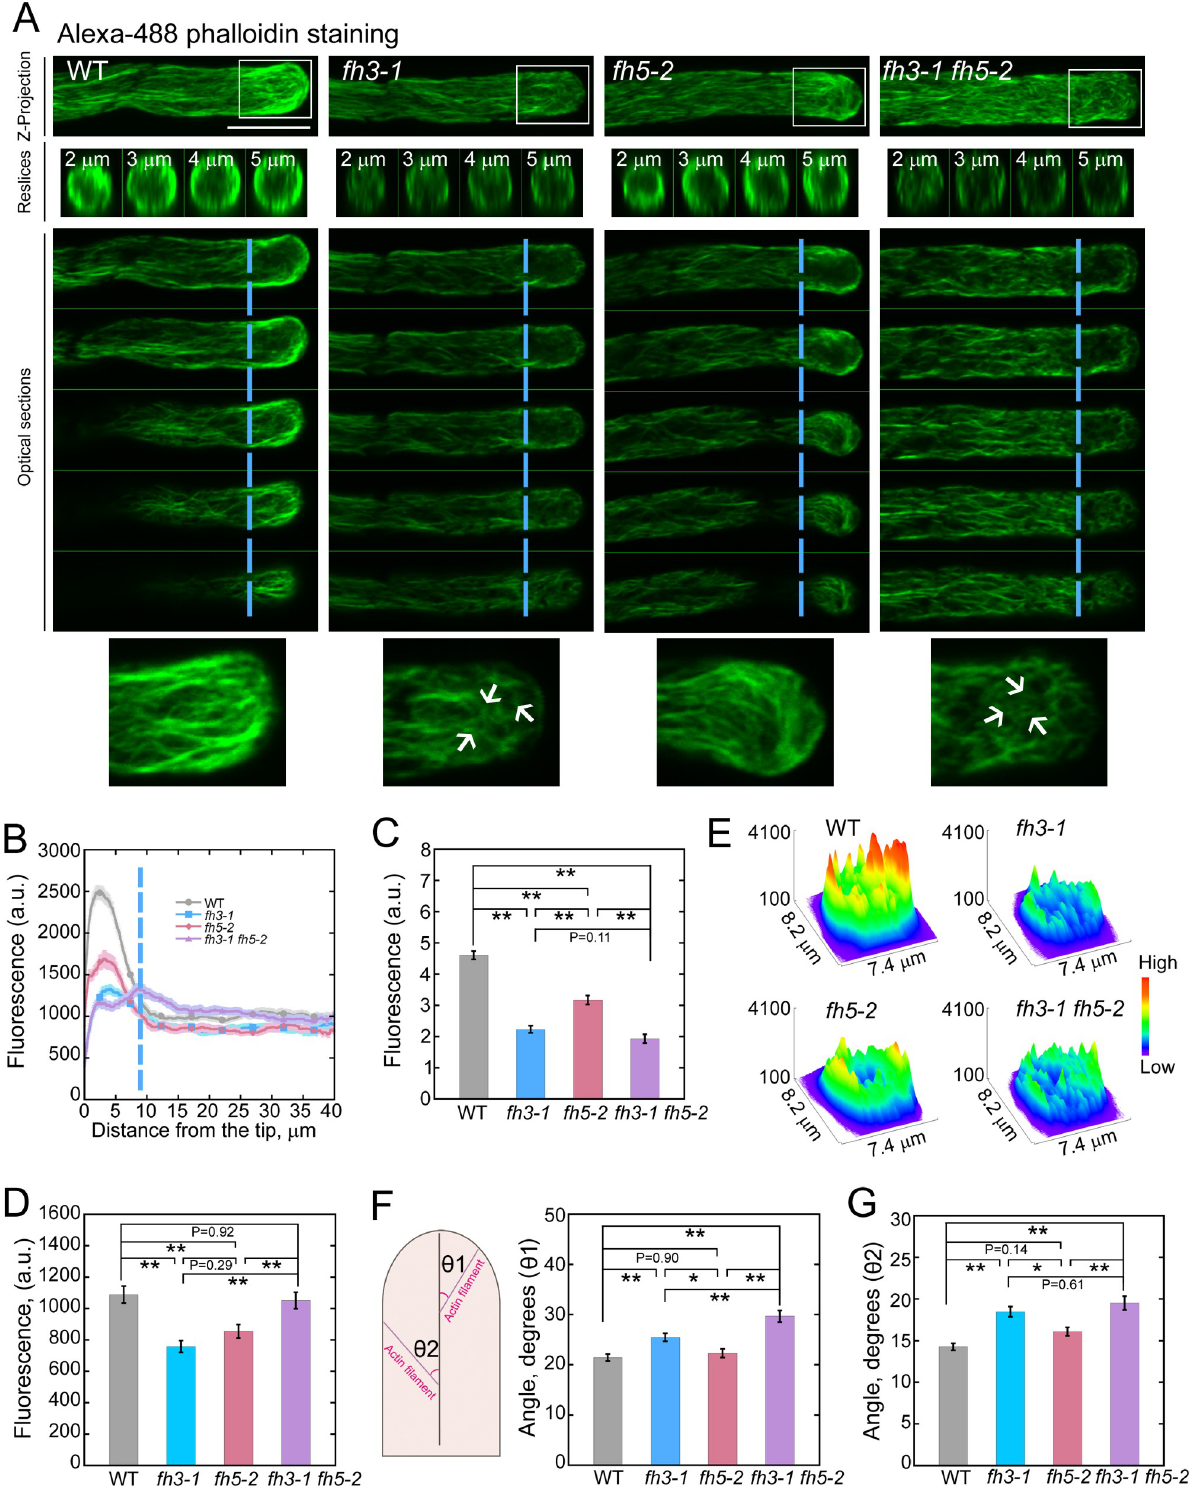
Fig 2. The amount of F-actin is reduced within the apical region of fh3 , fh5 , and fh3 fh5 pollen tubes. ( A ) Micrographs of pollen tubes stained with Alexa-488 phalloidin. For each genotype, the upper panel shows the Z-projection images. The reslices of transverse sections of the boxed region are shown (their distance from the tip is indicated on the image). The longitudinal sections of the stained pollen tubes are also presented and